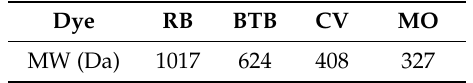
Table 2. The molecular weight (MW) of different dyes.